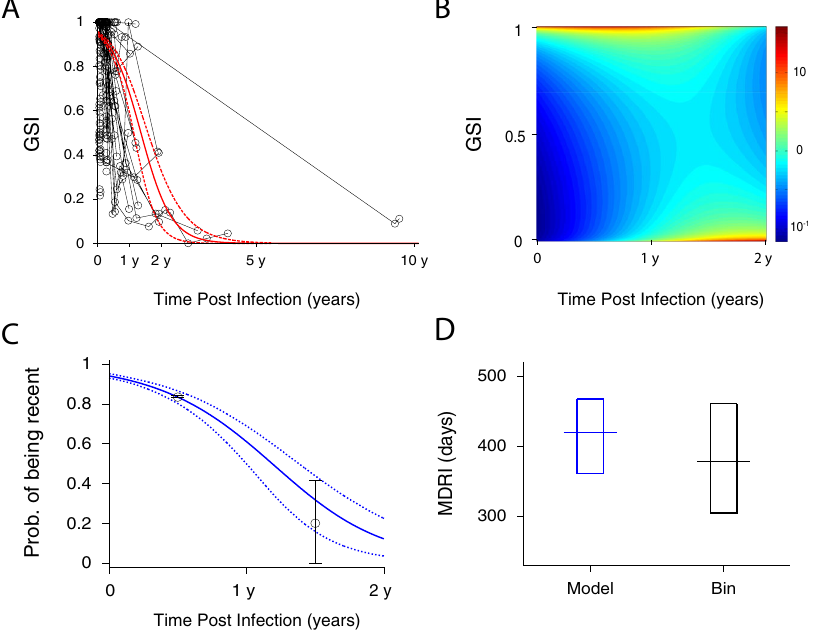
Figure 3. Genomic biomarker dynamics over time. ( A ) GSI dynamics of 194 longitudinal and 252 single time point incident specimens along with the beta distribution model fit. Forty three subjects in Table S3 were serially followed from Fiebig stage I-V (circles with black solid lines) and 252 single time point incident specimens were collected at Fiebig stage I-V (circles), as presented in Table S2. The GSI varies between individuals, but in the majority of cases is close to one for new infections and drops towards zero over time. The average biomarker dynamics were modeled by logistic link function and the variation between individuals was modeled by the beta distribution as in Eqs (2–3). The best fit of the model for the average GSI dynamics (solid red curve) and its 95% confidence intervals (CI) (dashed red curves) are presented. The maximum likelihood estimates of the model parameters are M = 495.8 [415.1–575.6], S = 176.8 [124.3–239.7], V = 0.96 [0.86–1.12] and c = 0.95 [0.94–0.96]. Each parameter’s 95% CI was obtained by resampling incident specimens’ biomarker data 10,000 times. The average biomarker’s 95% CI (dashed red curves) is the 95% CI of 10,000 fitted biomarker dynamics curves for each time point. ( B ) The density plot of the estimated GSI distribution over time. The GSI probability density function peaked (red) close to 1 during early infection and at 0 around two years post infection. However, around one year the density function peaked in both high and low GSI regions. These profiles collectively reflect the sequence data trends at the population level. The model estimate of the probability of being recent, defined in Eq. (4), is presented by a blue line and the proportion of subjects with GSI greater than the threshold in each one year bin is presented by black circles. The 95% CIs are presented by blue dashed curves and black lines, respectively. The beta distribution model was consistent with the one year bin evaluation. ( D ) The MDRI estimated by the model (blue), 420 [361–467] days, was compared with that from the bin-method (black), 378 [304–460]